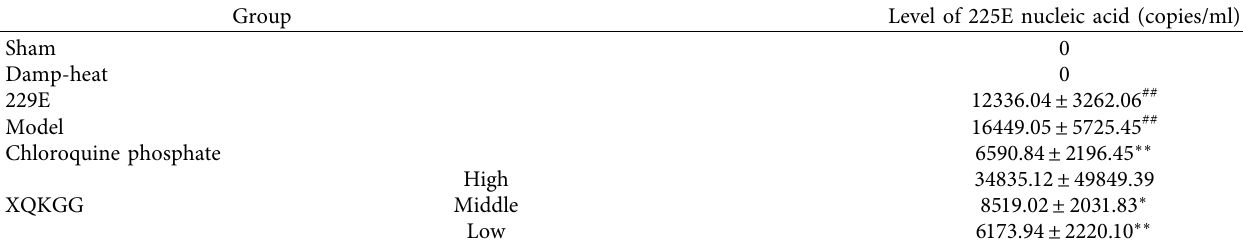
Table 2: Comparison of the levels of virus in lung tissue in groups ( n � 6).